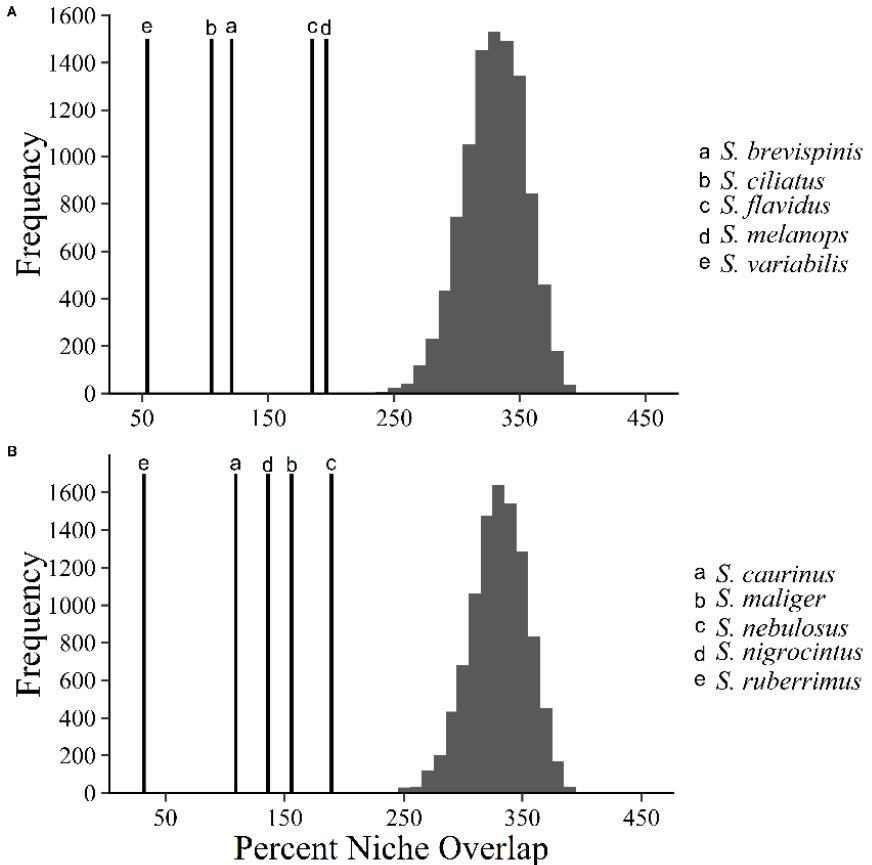
Figure 5. Comparison of cumulative trophic niche overlap for pelagic and demersal rockfish. Dis- tributions of the cumulative percent trophic niche overlap based on the resampling of the isotopic values (i.e., null model) for pelagic ( A ) or demersal rockfish ( B ). Observed cumulative percent trophic niche overlap of each rockfish species is represented by the bolded vertical lines.